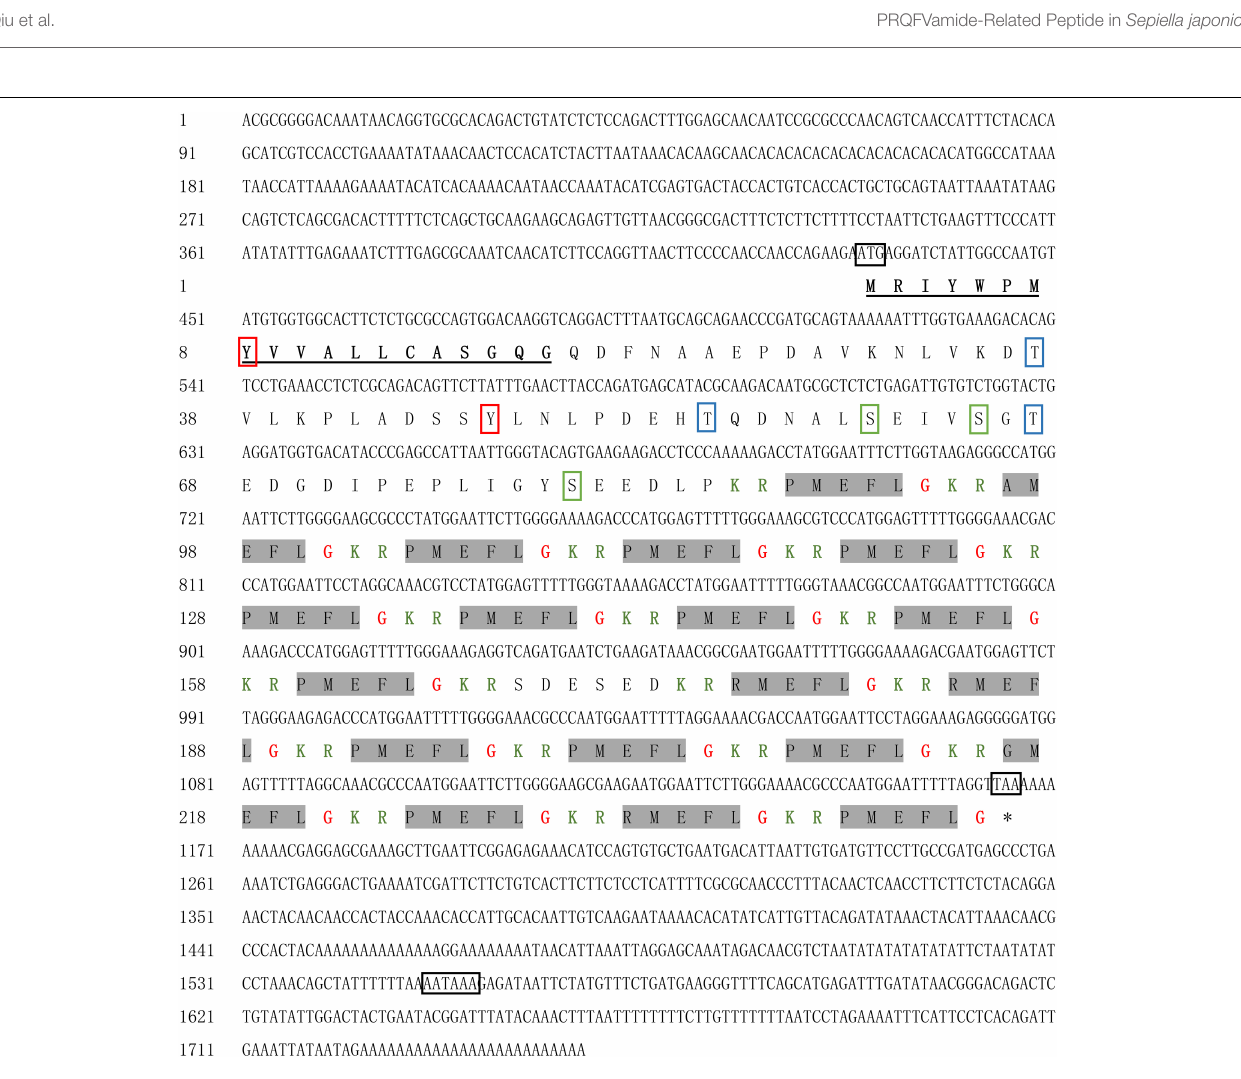
VA, United states) with TB Green R (cid:13) Premix Ex Taq TM II (Tli RNaseH Plus) (Takara, Kyodo, Japan). GAPDH (Huo et al., 2018) and β -actin (JN564496.1) were taken as